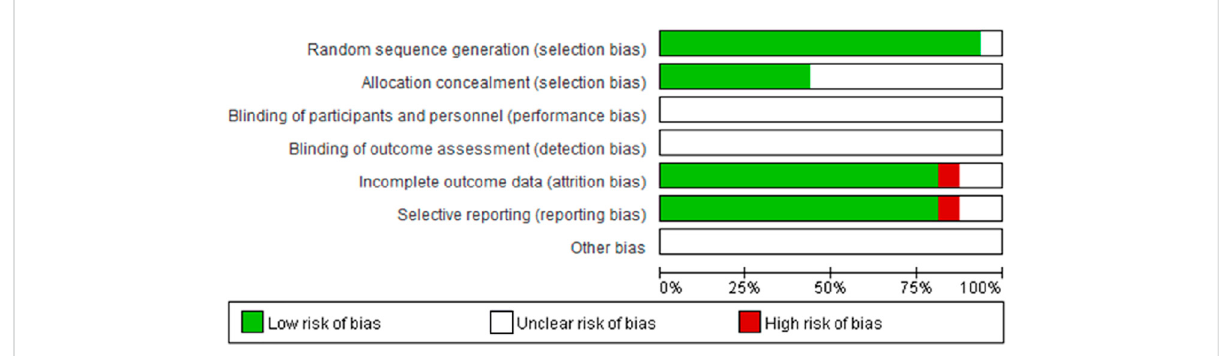
FIGURE 2 Risk-of-bias